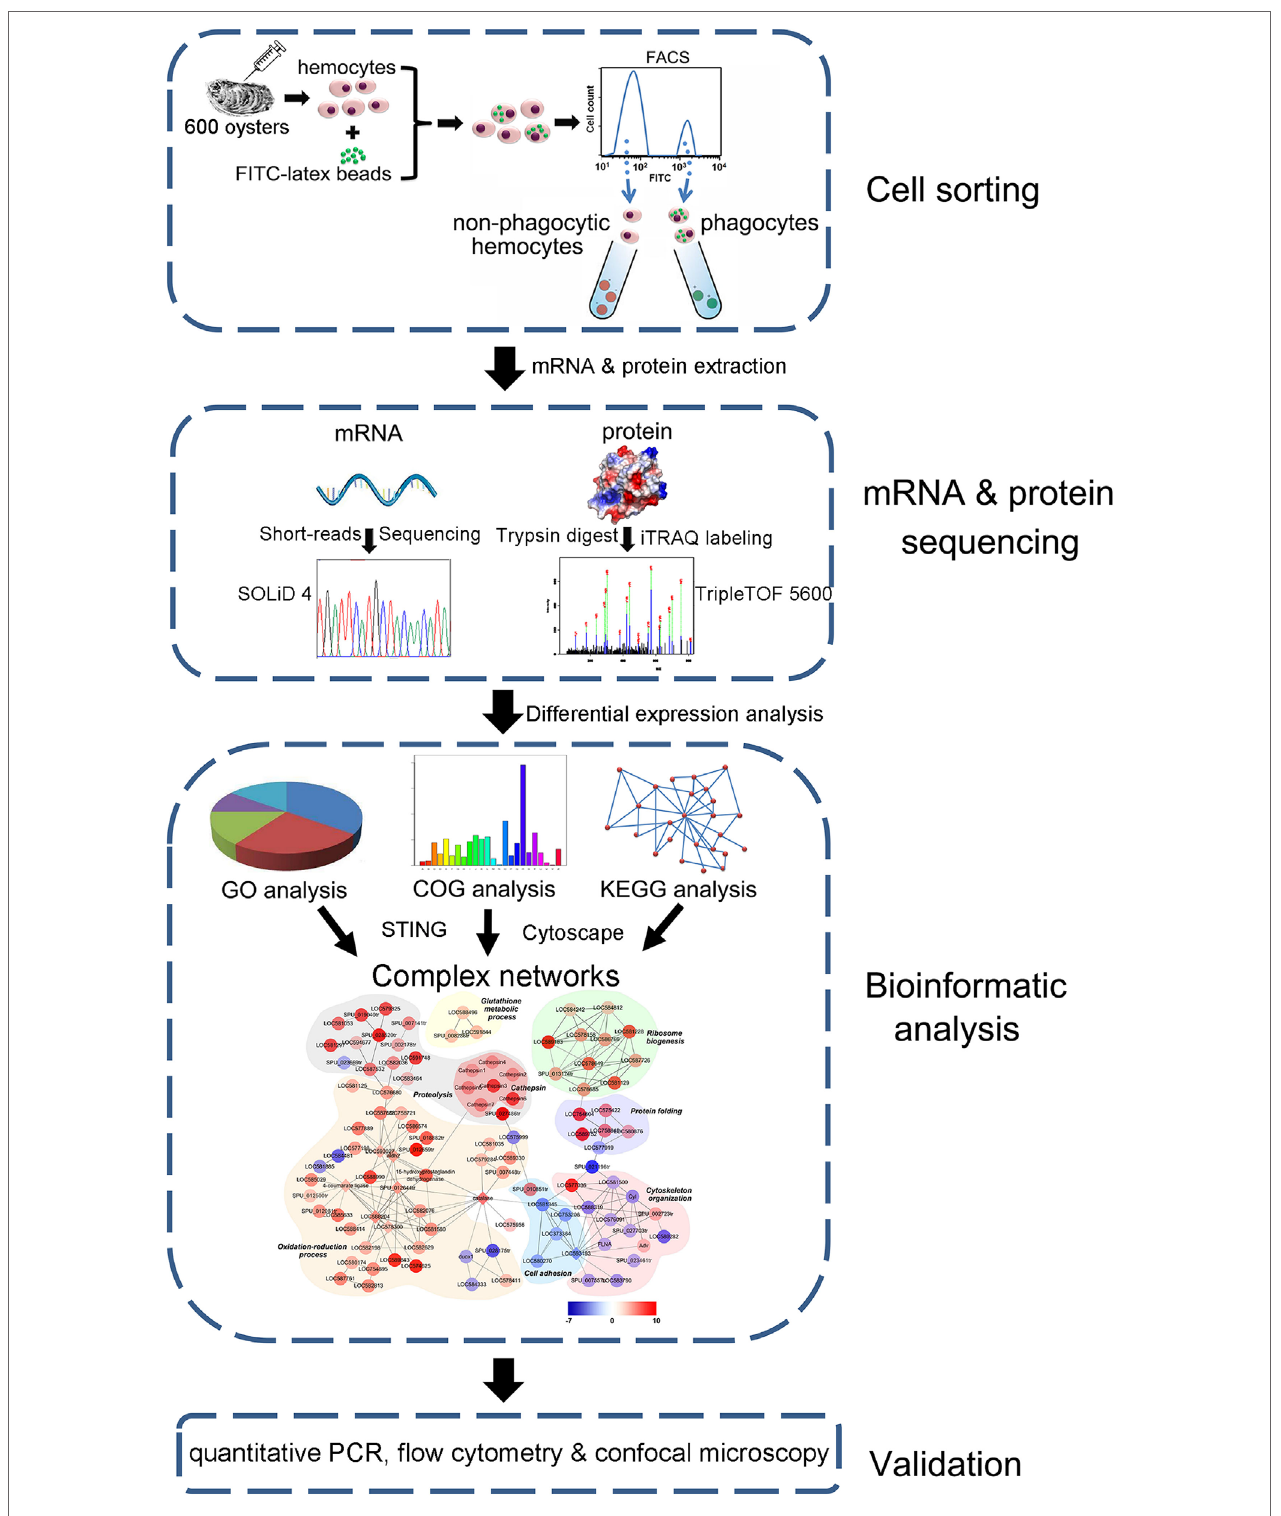
FigUre 1 | Pipeline overview of transcriptome and proteome analysis of Crassostrea gigas phagocytes. The hemocytes are collected, incubated with FITC-labeled latex beads, and sorted using FACS to prepare both phagocytes and non-phagocytic hemocytes. Differential expression in phagocytes is revealed using both transcriptome and quantitative proteome analyses. A complex network is constructed based on differentially expressed proteins and further validated using qPCR, flow cytometry, and confocal